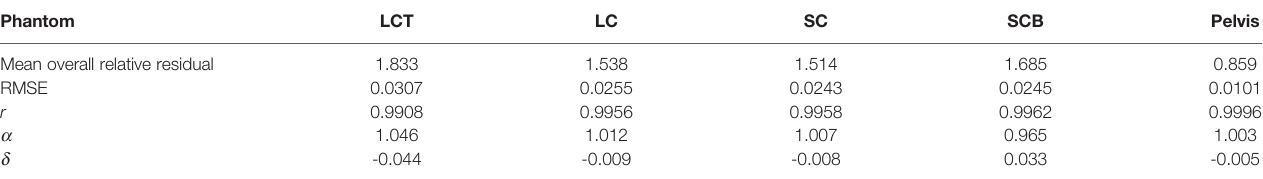
TABLE 2 | Accuracy of SECT-based SPR predictions across fi ve different PMMA phantoms: LCT ( “ long cylinder thin ” ) phantom, LC ( “ long cylinder ” ) phantom, SC ( “ short cylinder ” ) phantom, SCB ( “ short cylinder big ” ) phantom, and a roughly human-shaped pelvis. Phantom